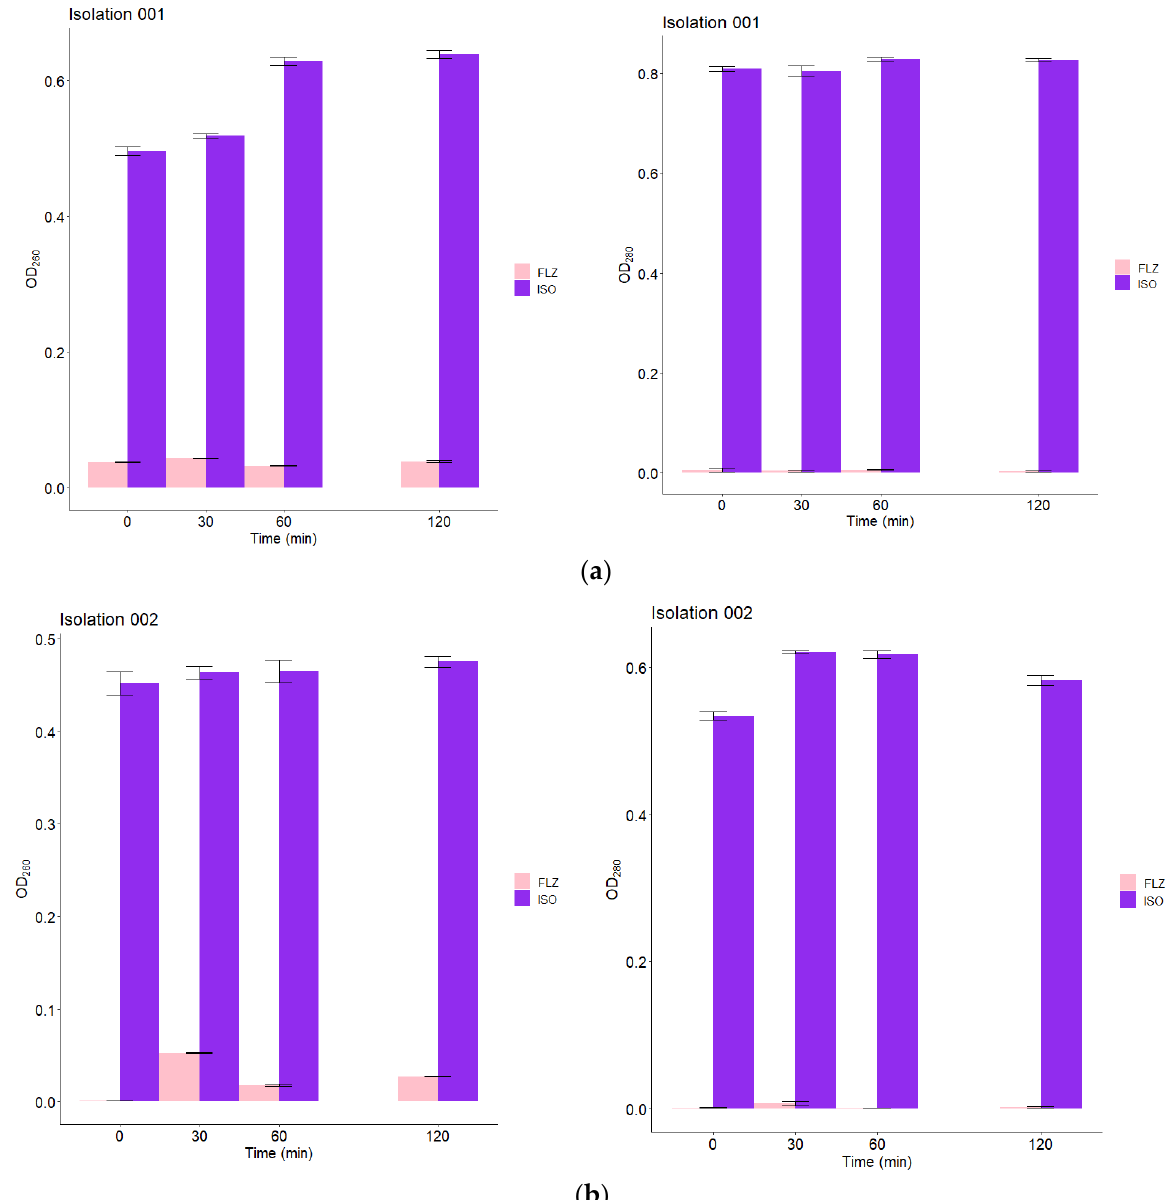
Figure 8. Release of intracellular content at 260/280 nm versus time of C. tropicalis treated with ISO (MIC µg/mL) and FLZ (MIC µg/mL). The figure shows the OD260/OD280 values of isolate 001 ( a ) and isolate 002 ( b ) treated with ISO and FLZ at different times. Results are expressed as the absorbance of the sample (treated with ISO) minus the absorbance of the control (samples without ISO). The results of the ANOVA and the Tukey test with a confidence level of 95% show statistically significant differences between the effect of ISO and the effect of FLZ on the leakage of intracellular material from all C. tropicalis isolates in this study.